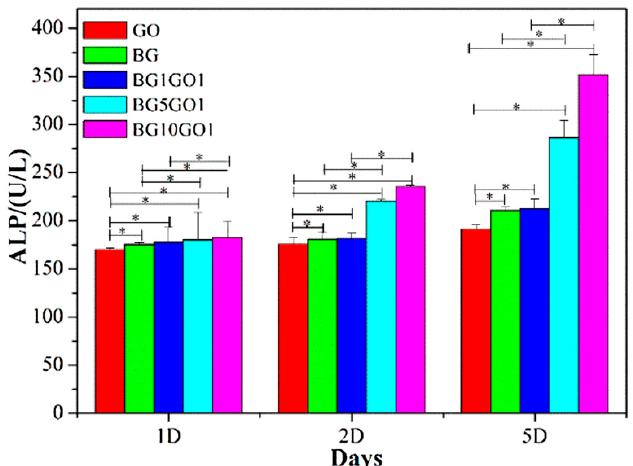
Figure 7. Alkaline phosphatase activity (Error bars indicate SD, n = 6. * indicates p < 0.05) [79] (copyright 2016, Colloids Surf. B: Biointerface).